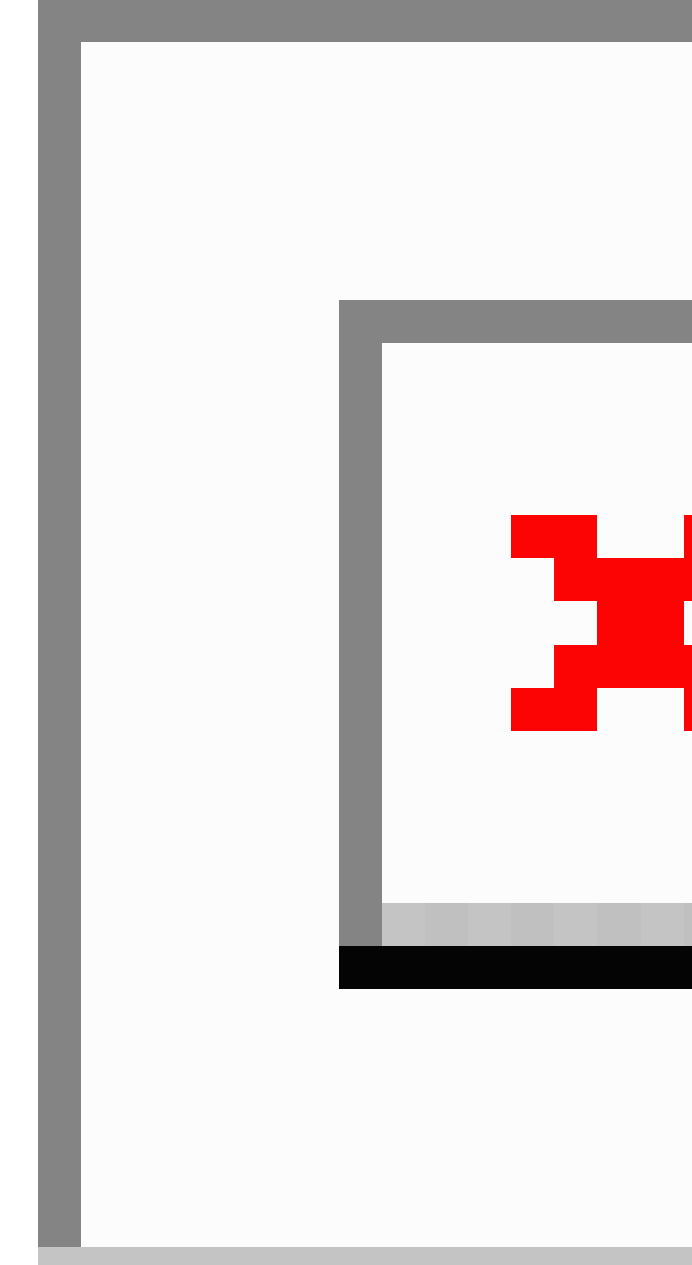
Figure 3. Screenshot showing an example of content and layout in the advice